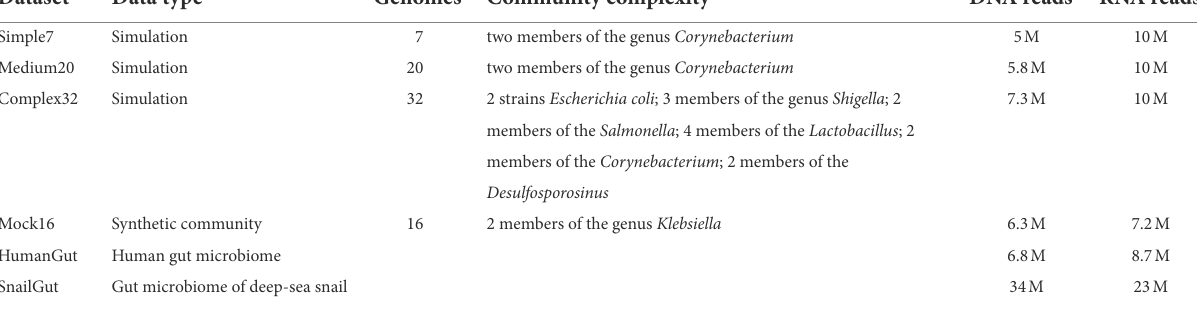
TABLE 1 Datasets used in this